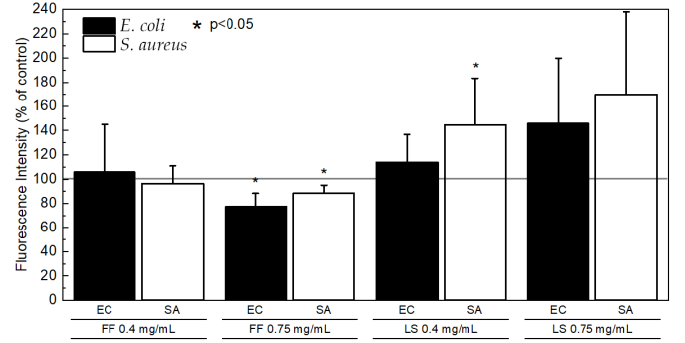
Figure 3. Membrane permeability for E. coli ATCC 25922 (black) and S. aureus ATCC 29213 (white) shown as percentage of control.